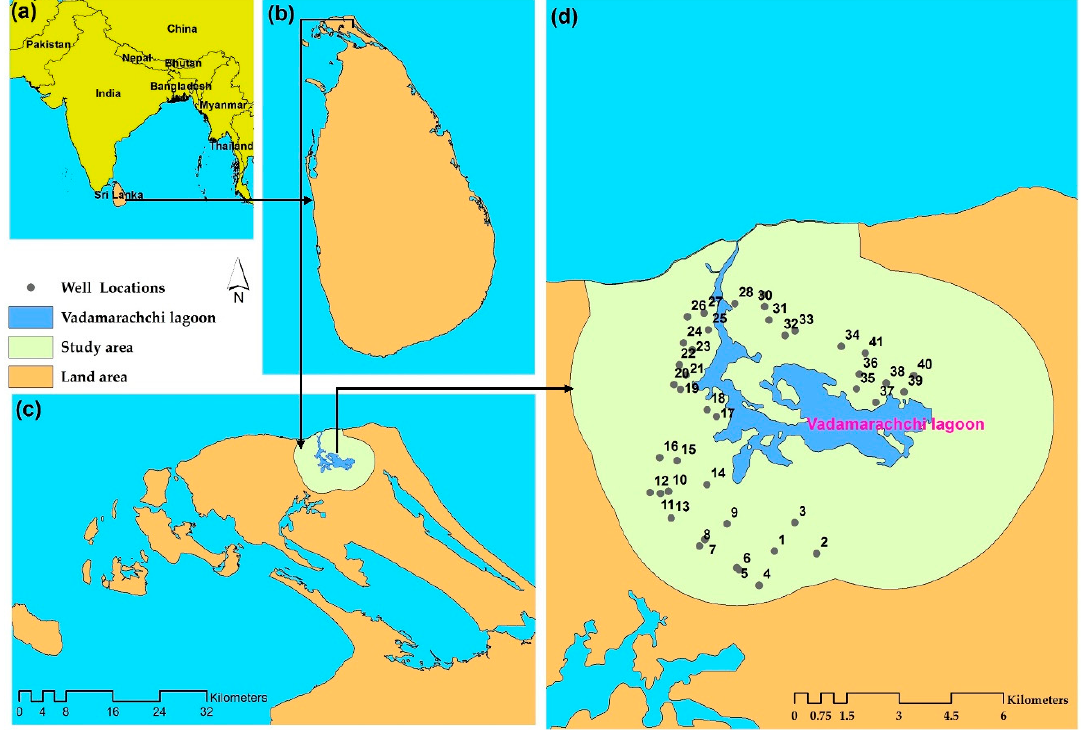
Figure 2. Location map of the study area ( a ) map of South Asia; ( b ) map of Sri Lanka; ( c ) location map of the Jaffna Peninsula; ( d ) location of Vadamarachchi lagoon and sampling well locations.